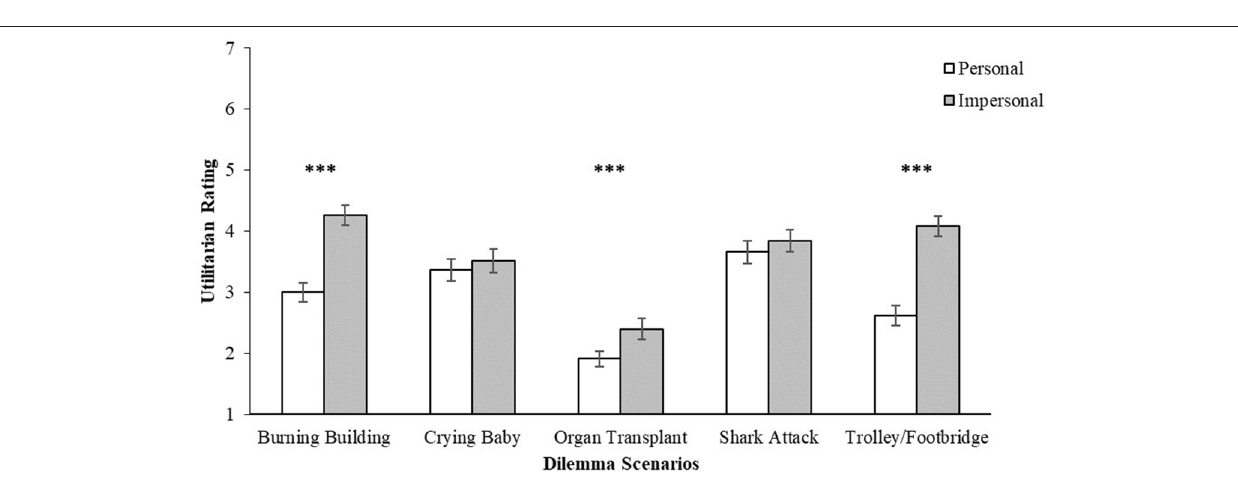
Frontiers in Psychology |